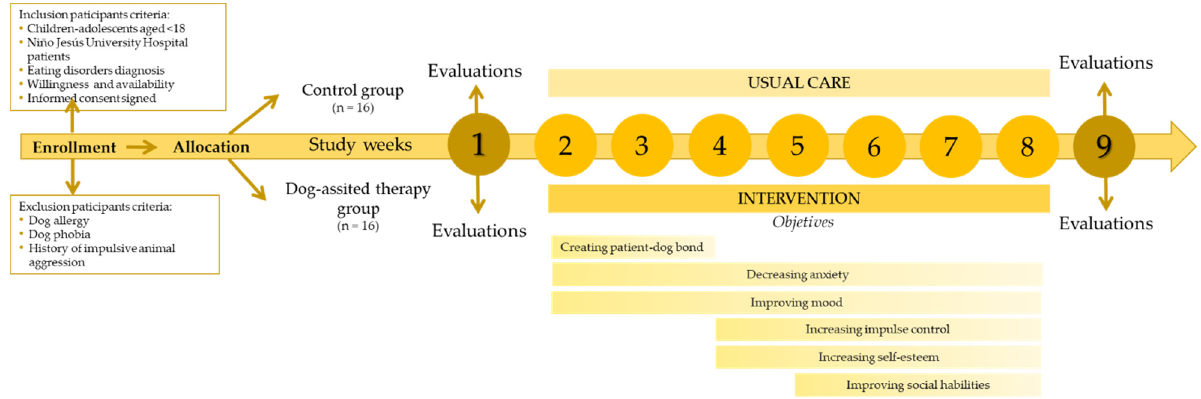
Figure 1. Study timeline and intervention objectives distribution during the dog ‐ assisted therapy sessions.